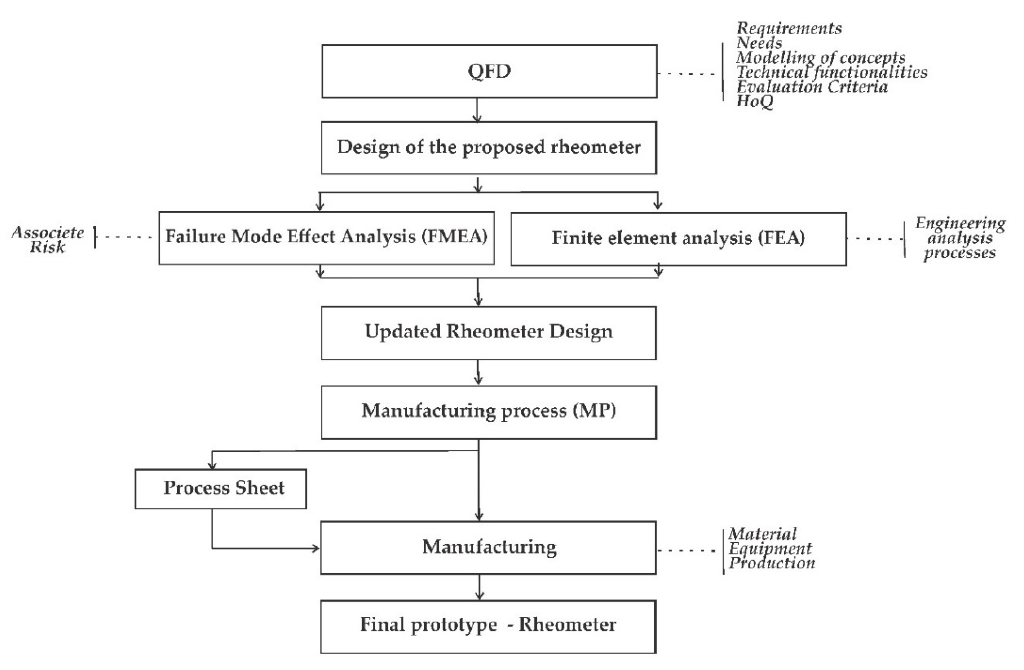
Figure 1. The methodological process.